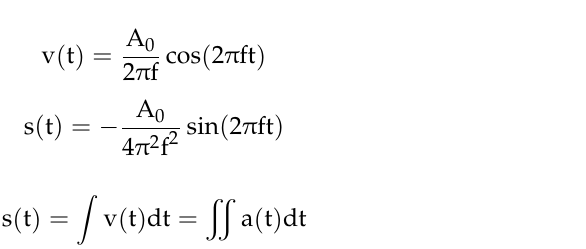
Figure 4. Experimental set-up for the metrological investigation of the piezoelectric Vibration Energy Harvesting (VEH).